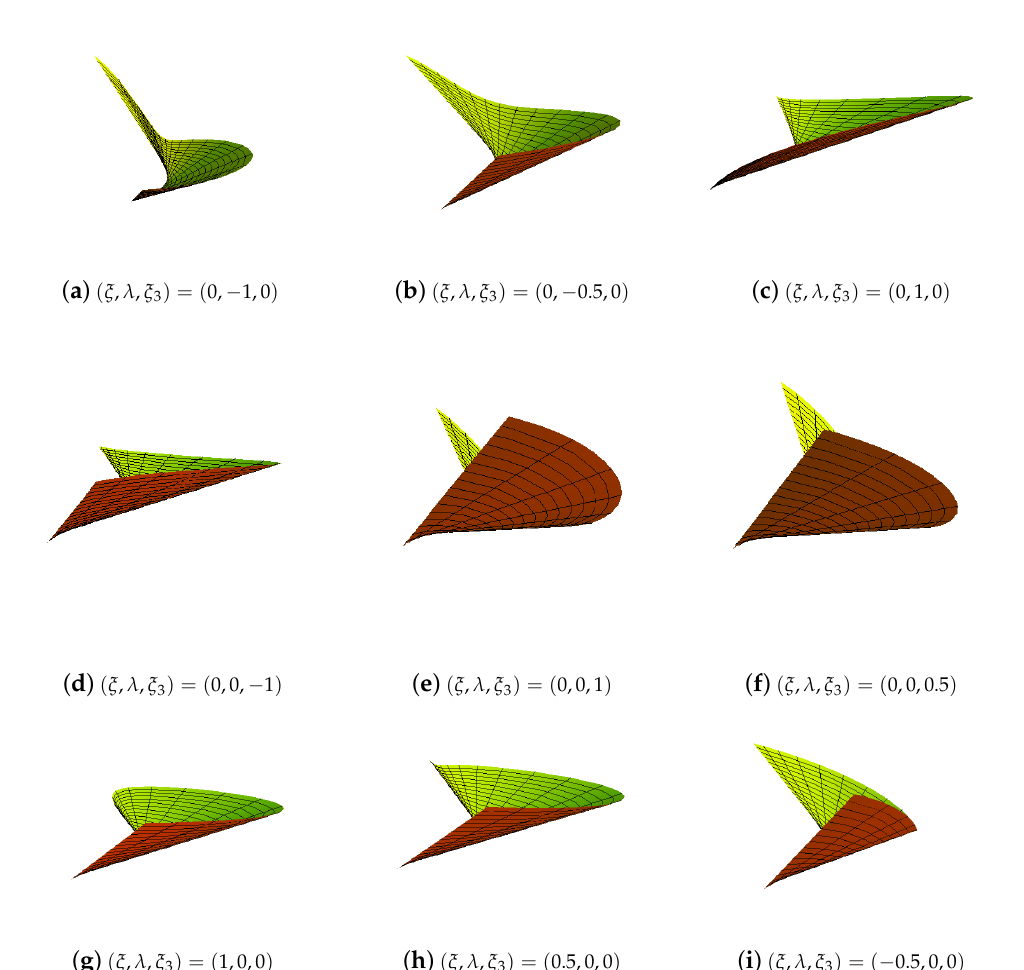
Figure 6. Graphical representation of Spine curve developable GHT-Bézier surfaces, having different values of ξ , λ , ξ 3